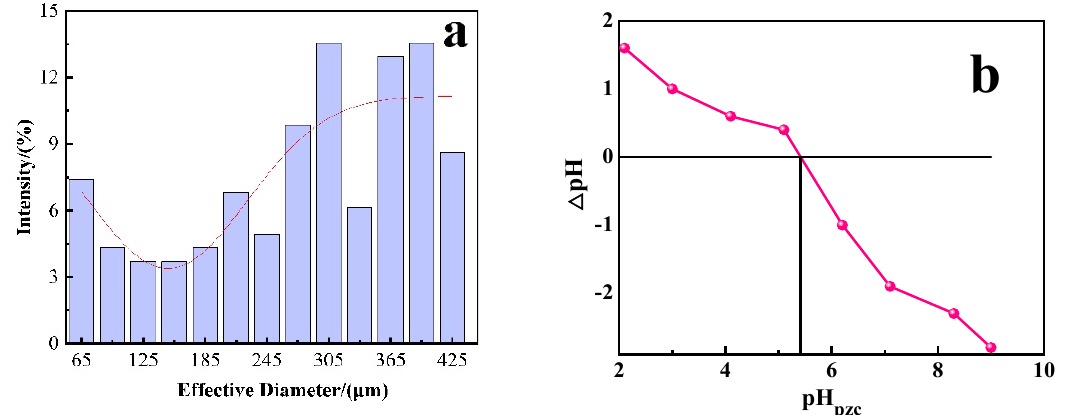
Figure 6. ( a ) Particle size distribution of PACMC. ( b ) Zero potential of PACMC at different pH (Adsorbent mass: 2 g · L − 1 , Temperature: 20 °C).